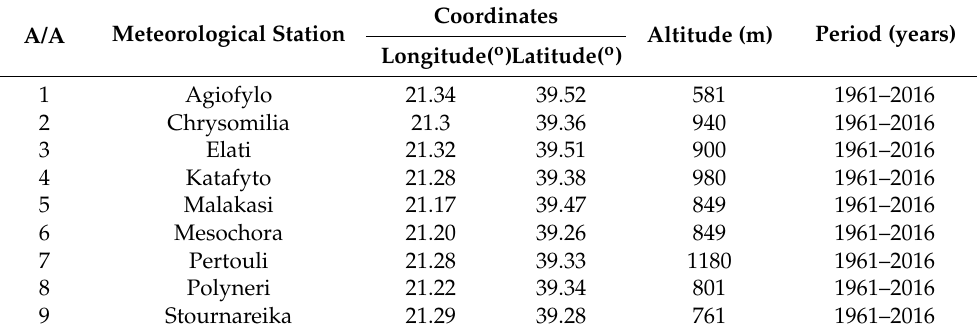
Table 1. Meteorological stations in the study area.